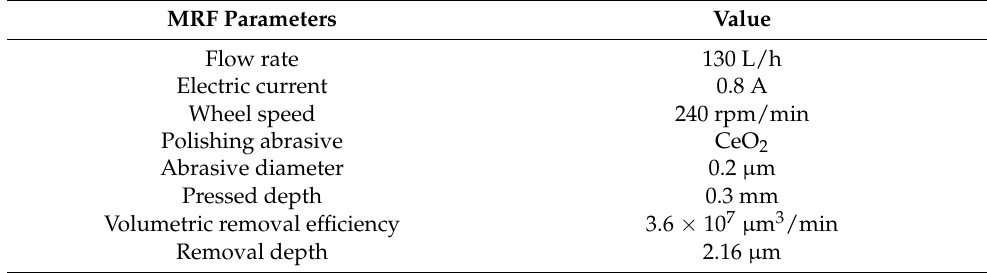
Table 1. Magnetorheological finishing (MRF) technique parameters of sample 2, 3, 4.